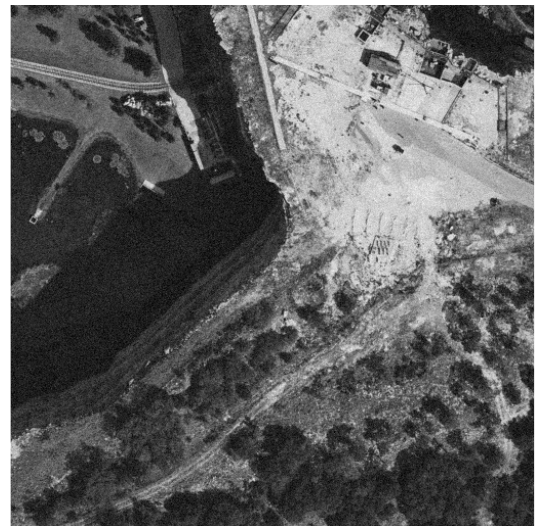
Figure 6. Noisy test image FR04 ( σ 2 = 100, peak signal-to-noise ratio (PSNR) inp = 28.11 dB, PHVSM out = 32.17 dB).